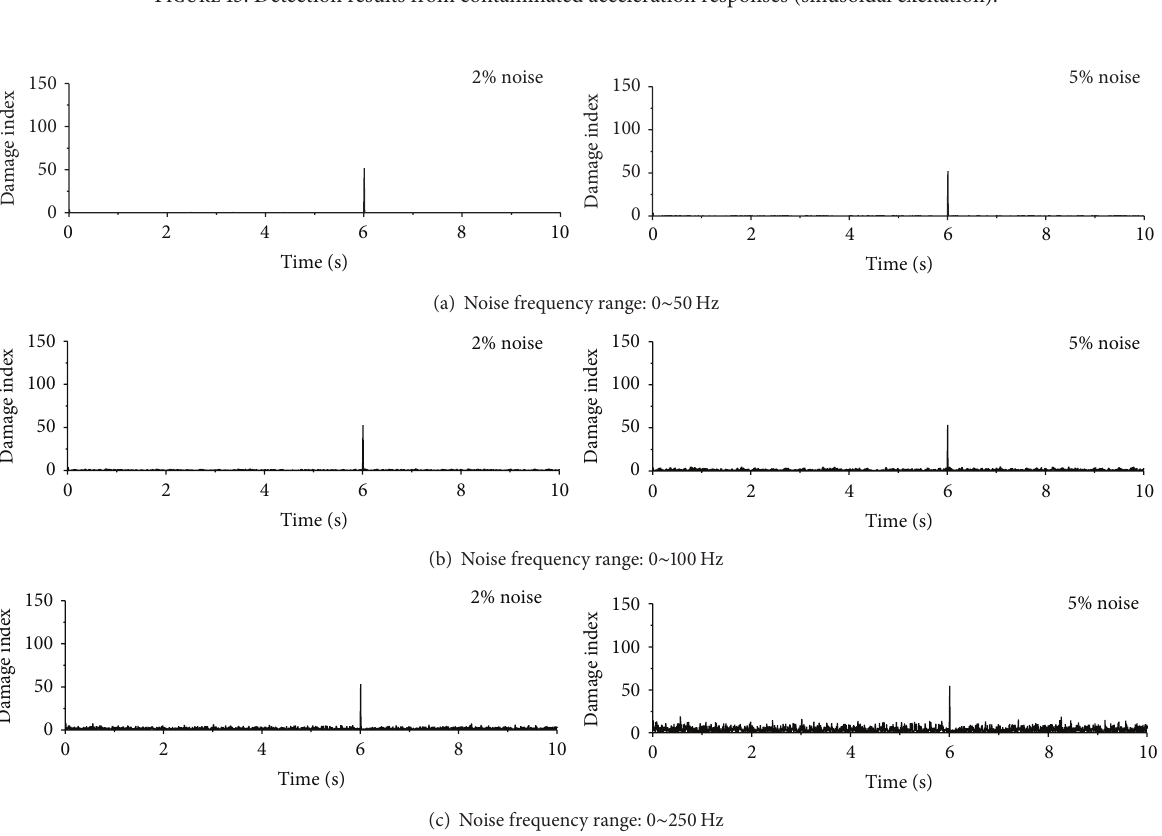
Figure 16: Detection results from contaminated acceleration responses (seismic